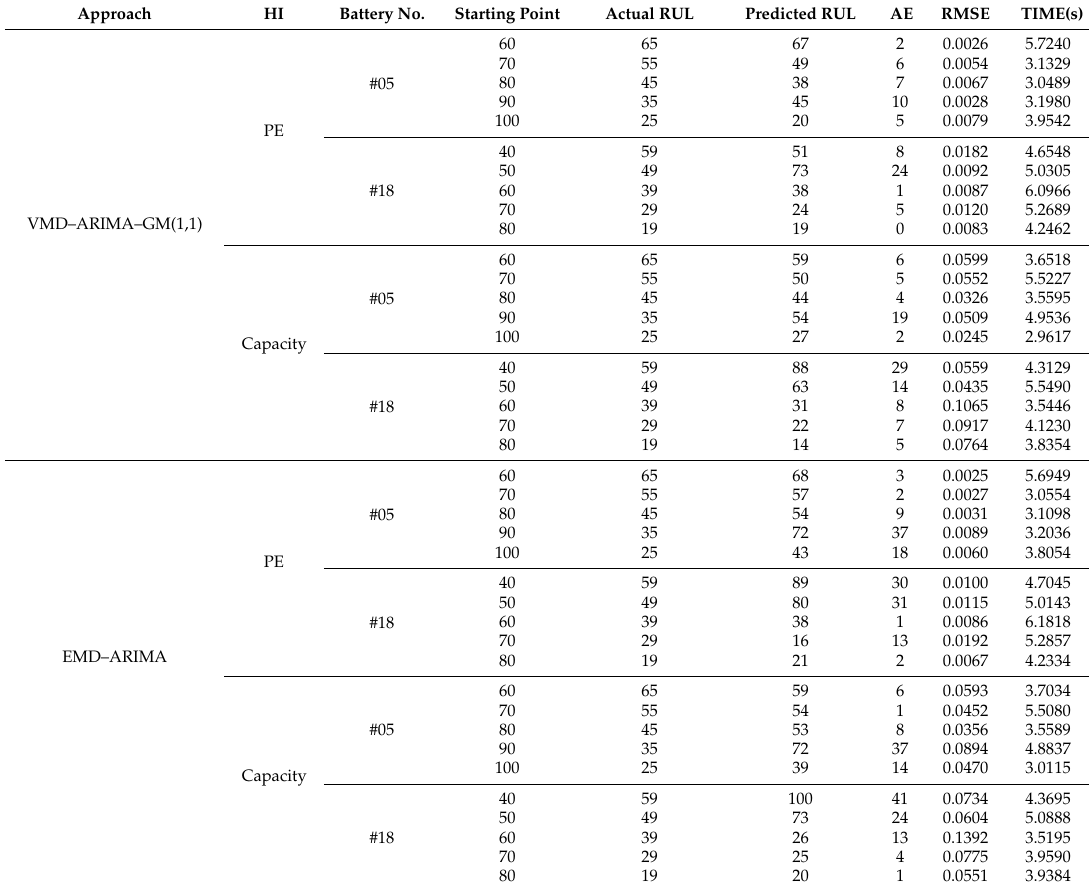
Table 3. RUL prediction performance base on PE compared with